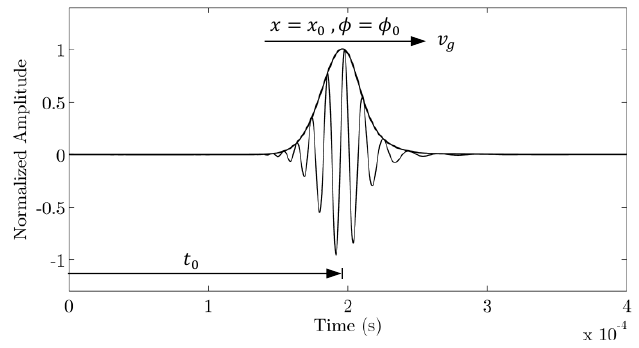
Figure 1. Wavepacket arriving at 𝑥 0 at time 𝑡 0 with phase 𝜙 0 propagating at group velocity 𝑣 𝑔 . 𝐺(𝑡) is represented as the envelope of the wavepacket.